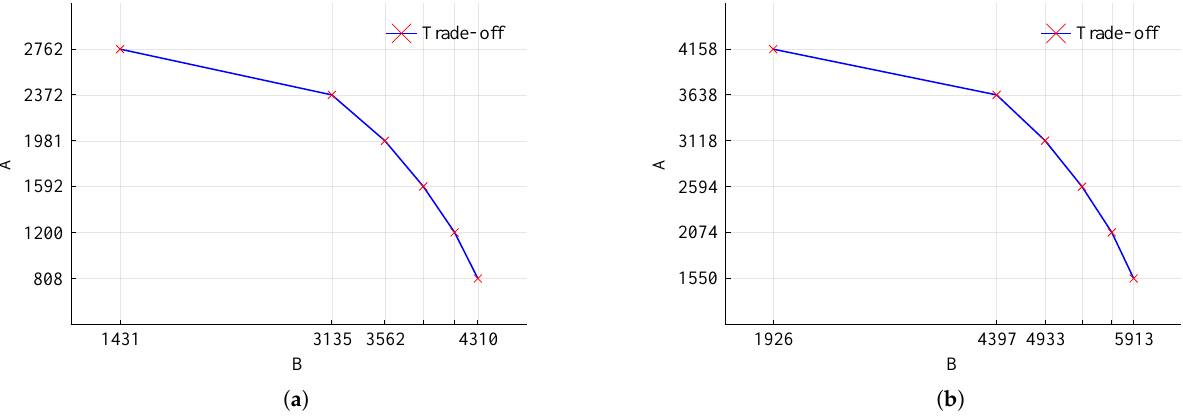
Figure 5. Pareto-optimal solutions for two constellations of varying sizes, considering the objective value for collective (A) and individual (B) tasks obtained withing a GAP ≤ 1%. ( a ) Constellation with two satellites. ( b ) Constellation with three satellites.